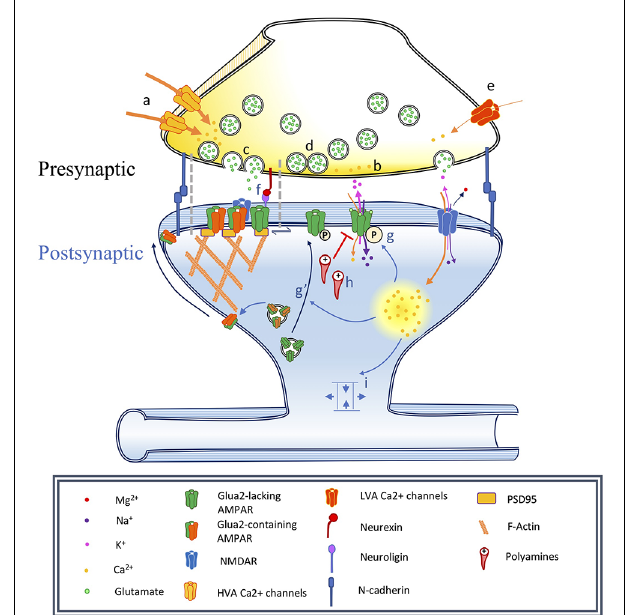
FIGURE 1 | Changes associated with long-term potentiation and synaptic maturation. Under basal conditions synapses are adhesive junctions between a presynaptic terminal containing neurotransmitter vesicles and Ca 2 + -dependent release machinery, in close proximity to a postsynaptic